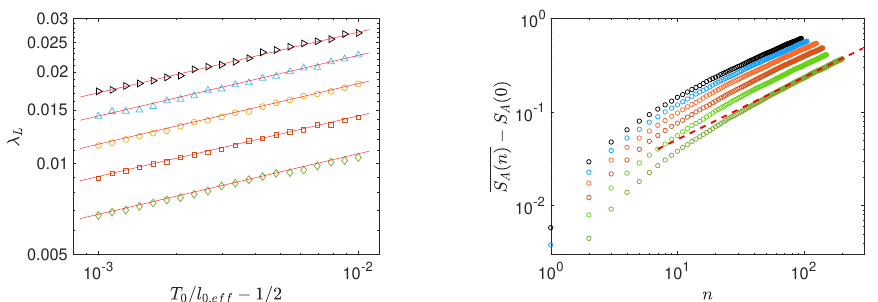
Figure 28: Left: Scaling of λ near the type II exceptional point in Fig. 27. From top L / l = 0.09, 0.08, 0.07, 0.06, and 0.05 (see Fig. 27). The solid to bottom, we have T 1 red lines are fittings with y ∝ x 0.2 . Right: The ensemble-averaged entanglement / l = 1 / 2 and (from top to bottom) entropy at the type II exceptional point with T 0 0,eff / l = 0.09, 0.08, 0.07, 0.06, 0.05, and 0.04. The red dashed line is a guiding line T (cid:112) 1 x with y ∝